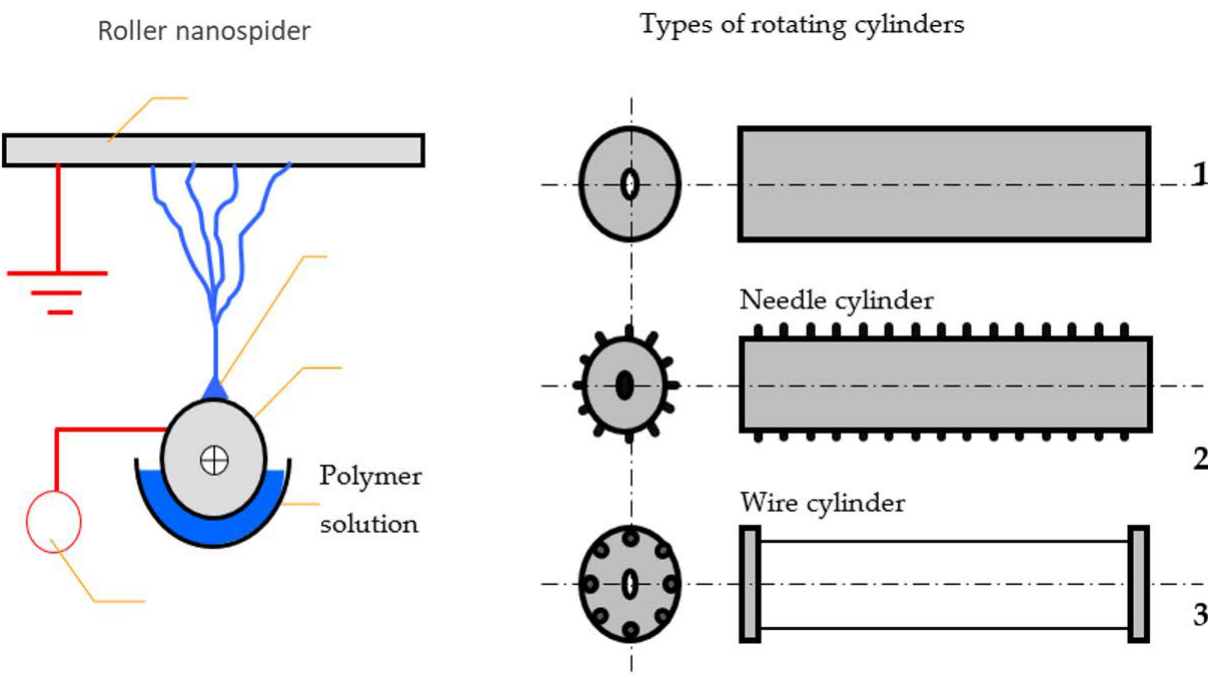
Figure 11. Diagram of the Nanospider method with different types of spinning electrodes (1—smooth cylinder, 2—needle cylinder, 3—wire